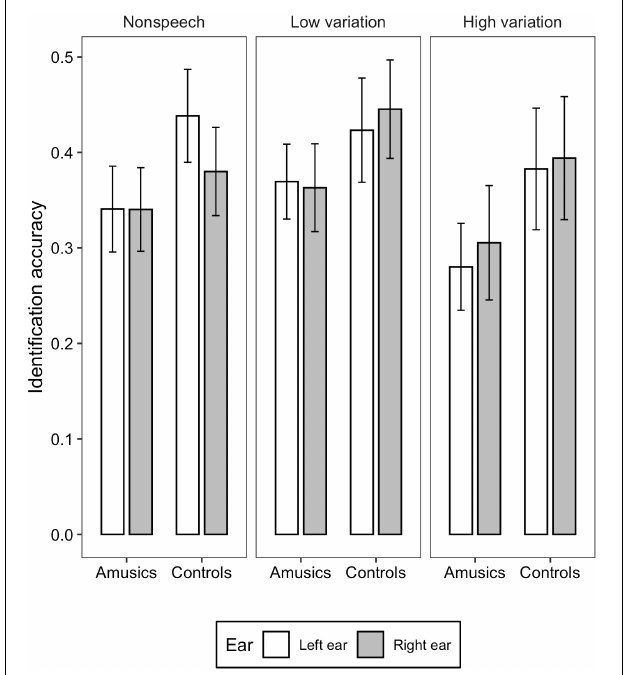
FIGURE 1 | Bar charts showing the identification accuracy (means and CIs) in each ear for amusic and control participants in the three stimulus conditions: Non-speech, Low variation, and High variation.